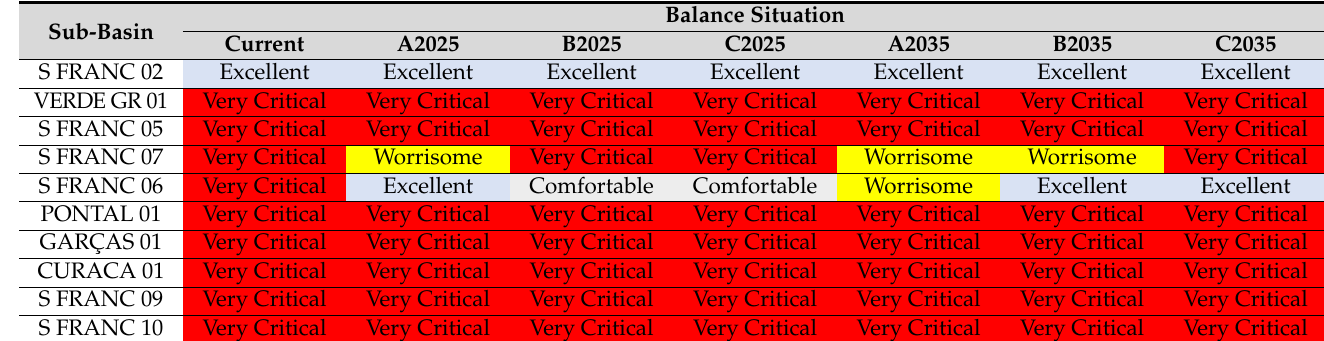
Table 8. Examples of surface water balance (Acquanet)—farming. See Table 3 for the corresponding classification. See Supplementary Materials S9.